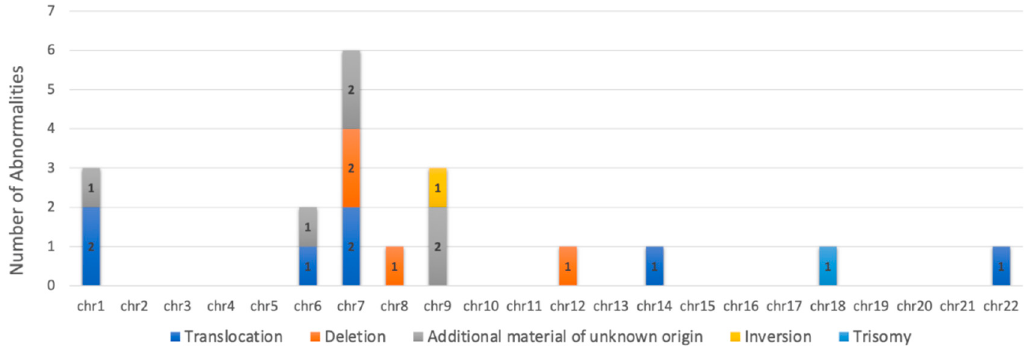
Figure 2. Number and type of chromosomal abnormalities seen in Castleman disease (CD) patients.